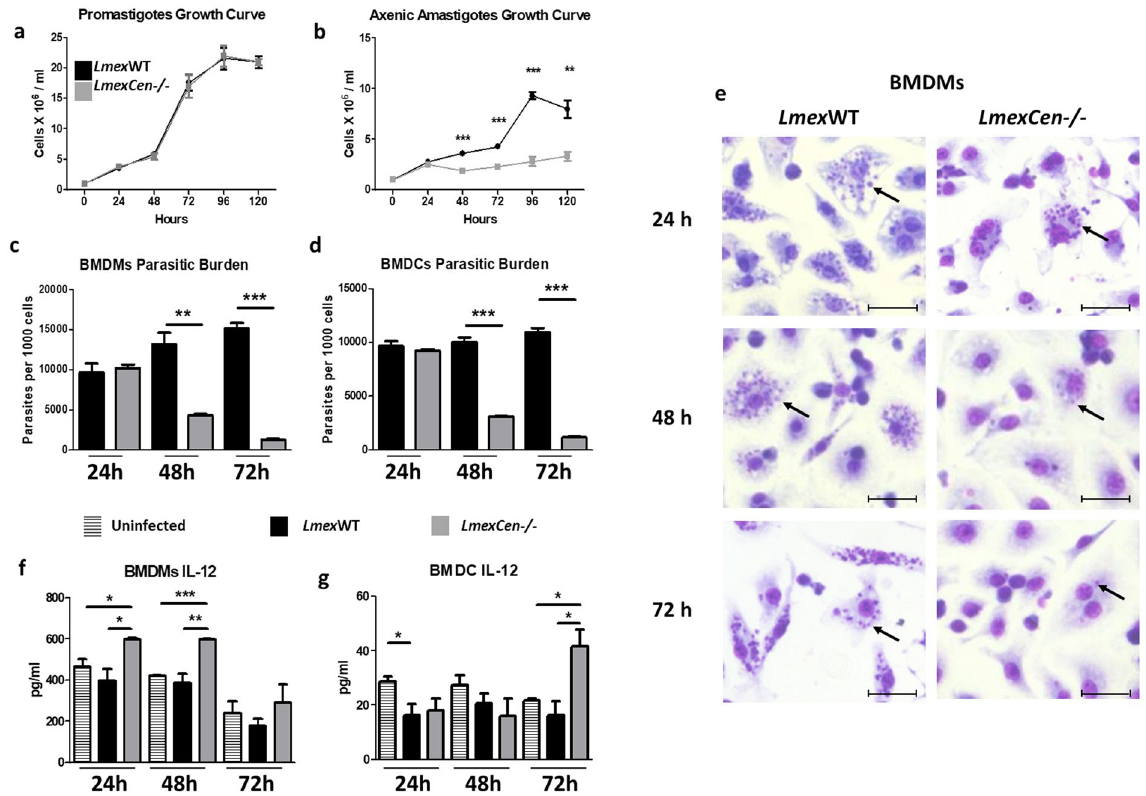
Fig. 2 LmexCen − / − parasites show diminished survival and virulence in bone-marrow-derived macrophages and dendritic cells. a, b Growth curve of LmexWT and LmexCen − / − promastigotes ( a ) and axenic amastigotes ( b ). c , d Parasitic burden in BALB/c-derived BMDMs ( c ) and BMDCs ( d ) infected with either LmexWT or LmexCen − / − promastigotes. e Representative Giemsa stain images of BMDMs incubated with either LmexWT or LmexCen − / − promastigotes. Examples of intracellular parasites are indicated by black arrows. Scale bar: 25,000 μ m. f , g IL-12 levels in BALB/c-derived BMDMs ( f ) and BMDCs ( g ) uninfected and infected with either LmexWT or LmexCen − / − promastigotes and then stimulated with 1 μ g/ml LPS. Data show one representative experiment out of three independent experiments and show mean ± SEM, N = 3 for each group at each time point. Unpaired two-tailed Student ’ s t -test was performed to compare statistical signi fi cance at each time point. A P -value < 0.05 was considered signi fi cant. In all panels * represents P ≤ 0.05, ** represents P ≤ 0.01, and *** represents P ≤ (Fig. 3h), compared to the LmexCen − / − group, which showed minimal parasitic persistence in the foot and no parasites detectable in the lymph nodes at 16 wpi and 24 wpi. A similar trend was seen in STAT4 − / − mice (Fig. 3i – j). The lack of symptoms and the limited parasitic persistence in LmexCen − / − inoculated mice con fi rm that, as opposed to Lmex WT, LmexCen − / − cannot properly establish and spread the infection, even in a permissive, immunocompromised host.